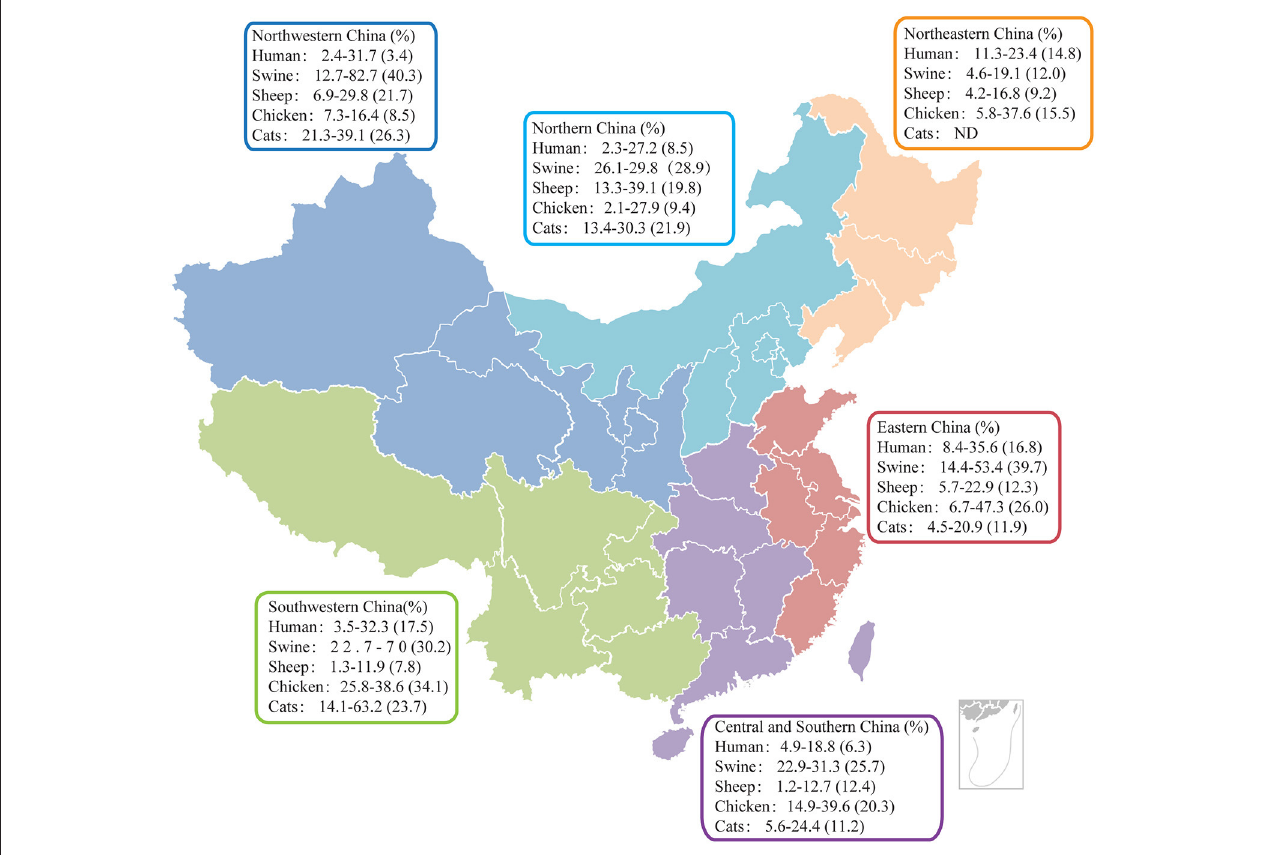
FIGURE 2 | Results of representative serological studies to estimate the prevalence of T. gondii in humans and animals in China. Data collected from both Chinese and English publications after the year 2010 were analyzed and graphed on the map of China, which was divided into six regions for data presentation. Sero-prevalence range and average (in parentheses) for each animal in each region are shown. ND, Not determined.